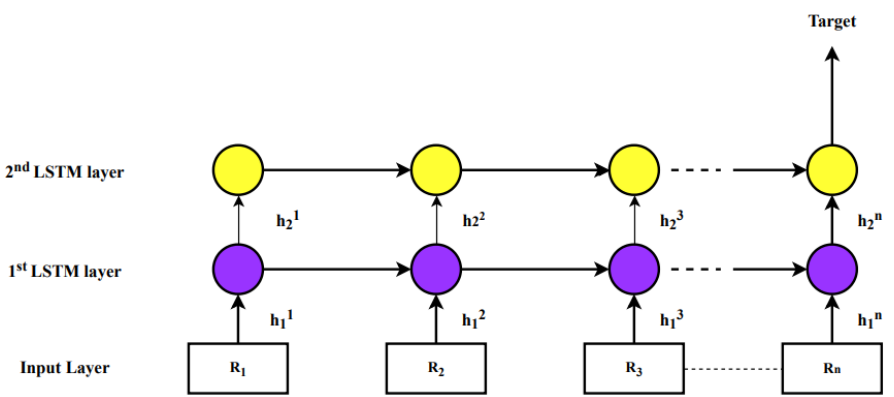
Figure 1. Structure of Hierarchical